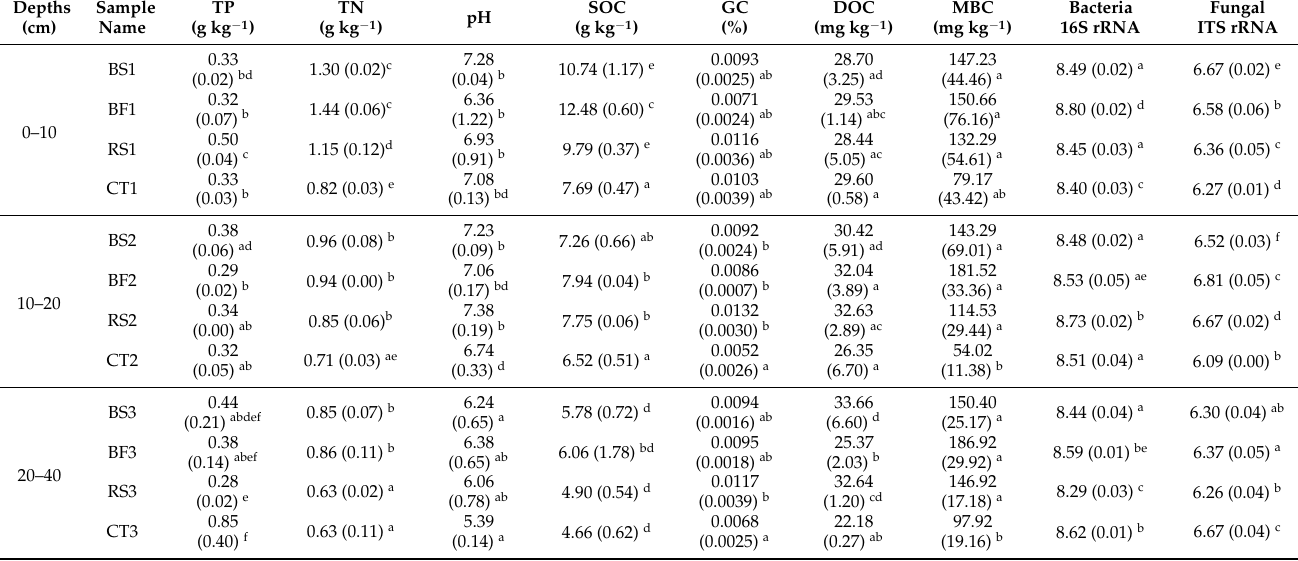
Table 1. Effect of soil and water conservation measures on soil physicochemical properties and the bacterial and fungal quantities based on a 16S rRNA gene sequence assignment dataset with a 97% sequence similarity